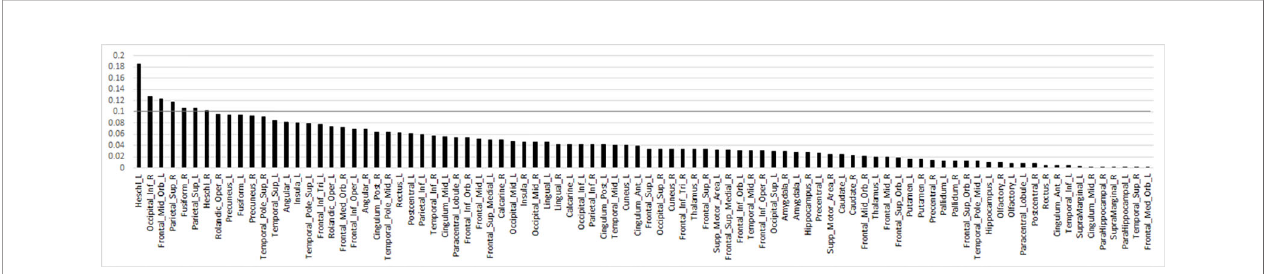
FIGURE 2 | Bar plot of the Fisher score ranks for anatomy-based regions of interest related to brain response to threat (>happy) faces in descending order. Line denotes arbitrary Fisher score cut-point of 0.10 to highlight regions that largely differentiated individuals with social anxiety disorder from healthy